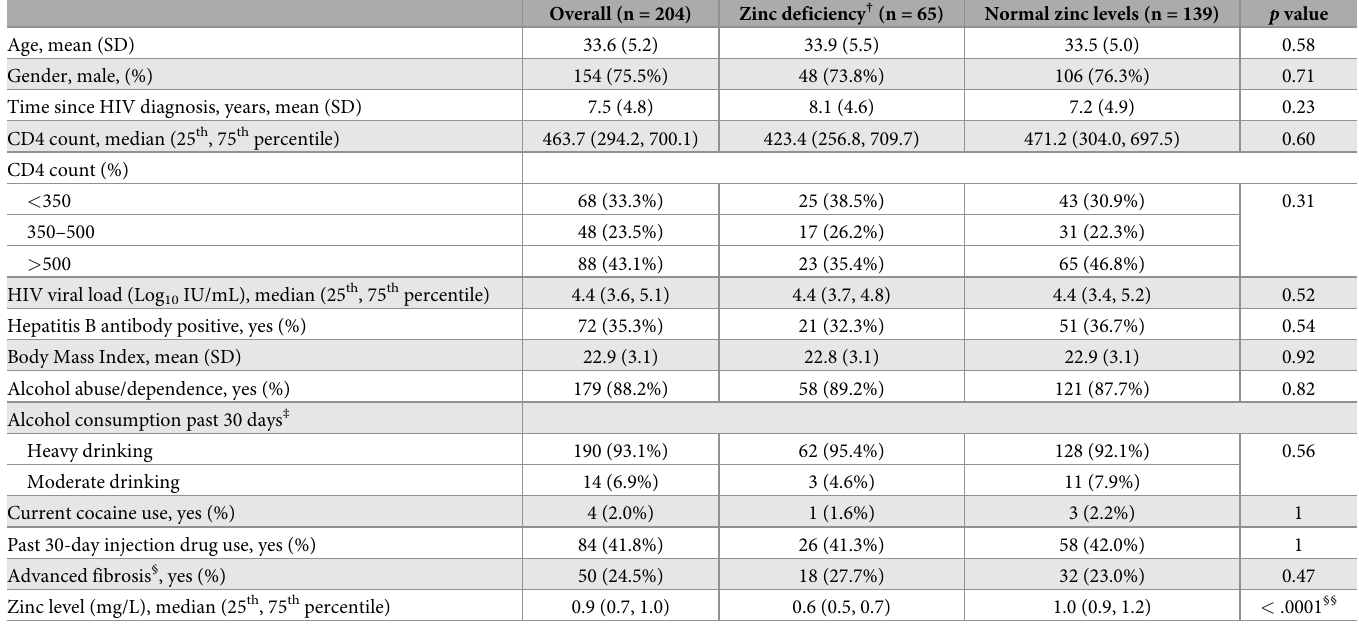
Table 1. Patient demographic and clinical characteristics of HIV and HCV co-infected ART na ï ve